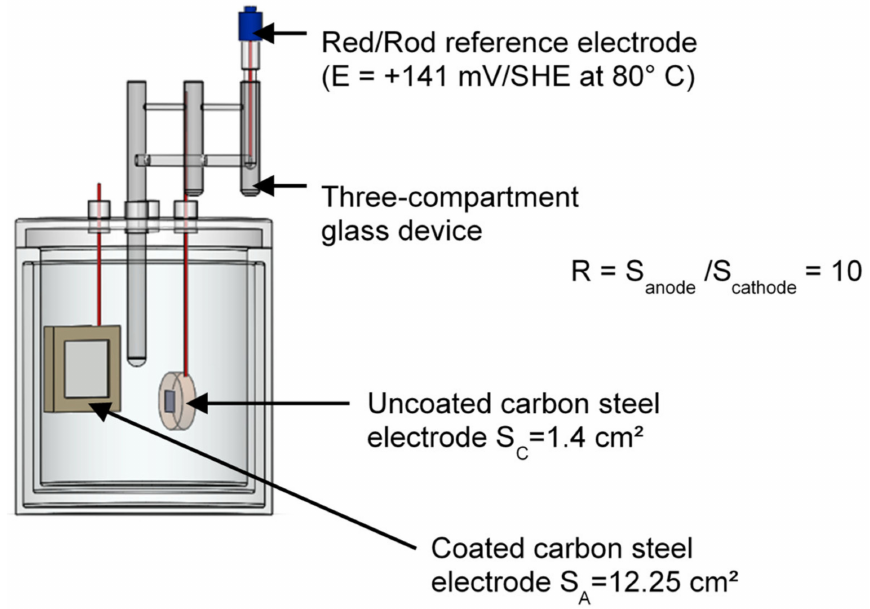
Figure 1. Schematic view of the electrochemical set-up used for galvanic corrosion